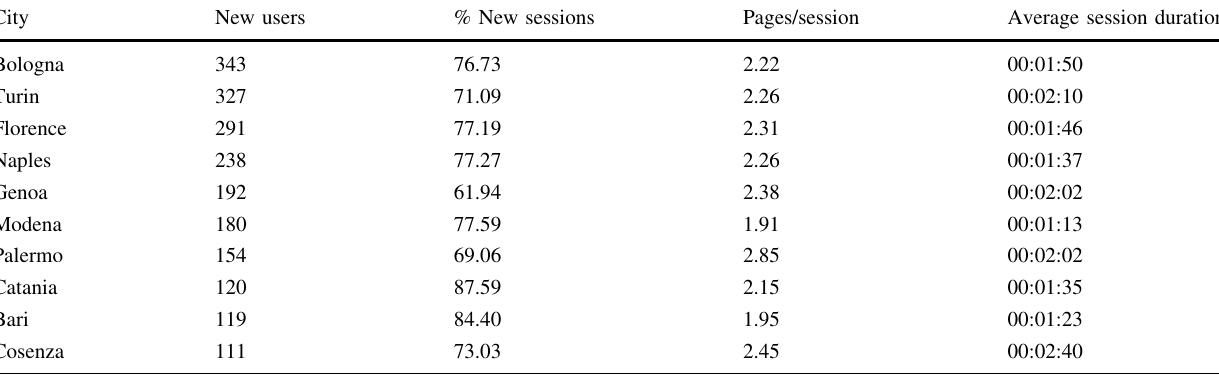
Fig. 4 Number of users (blue line) and new users (red line) at the #italiasicura website 19 to 28 November 2016 (left), and 1 to 25 September 2017 (right). Peaks occurred in the days immediately following the Piedmont (24 November 2016) and Livorno (9 September 2017) flood events